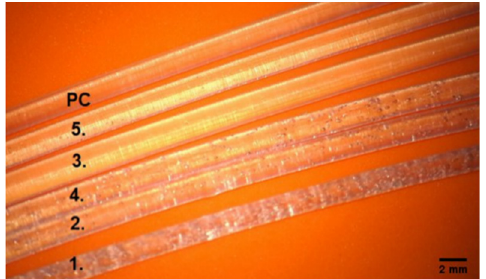
Figure 6. Pictures of the obtained filaments under the Carl ZEISS Vario700 microscope, 19 × magni- fication. Material in the order counting from the top No. 0-PC, subsequent filament numbers: 1–5, according to the composition from Table 1, filament diameter 1.75 mm.